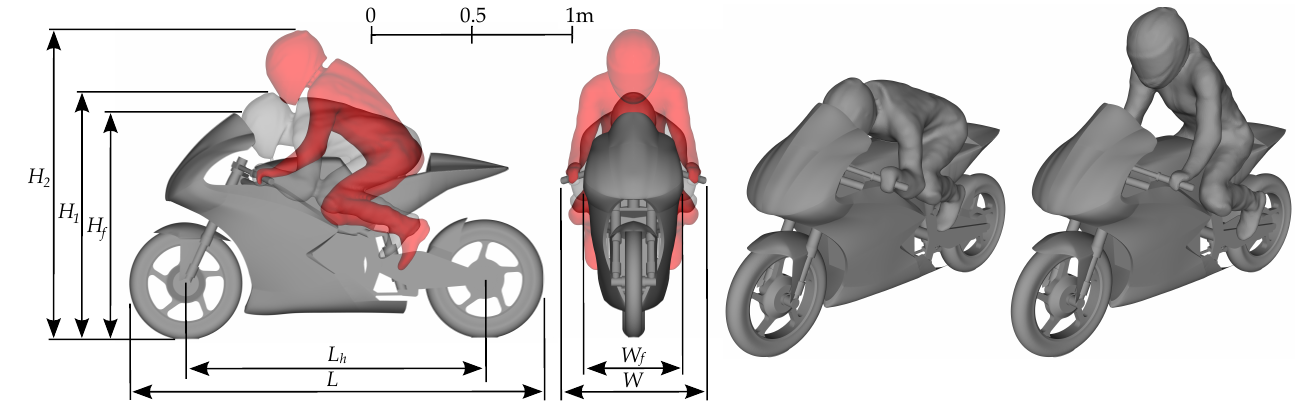
Figure 1. CAD model of MotoStudent class motorbike with rider in two different positions.